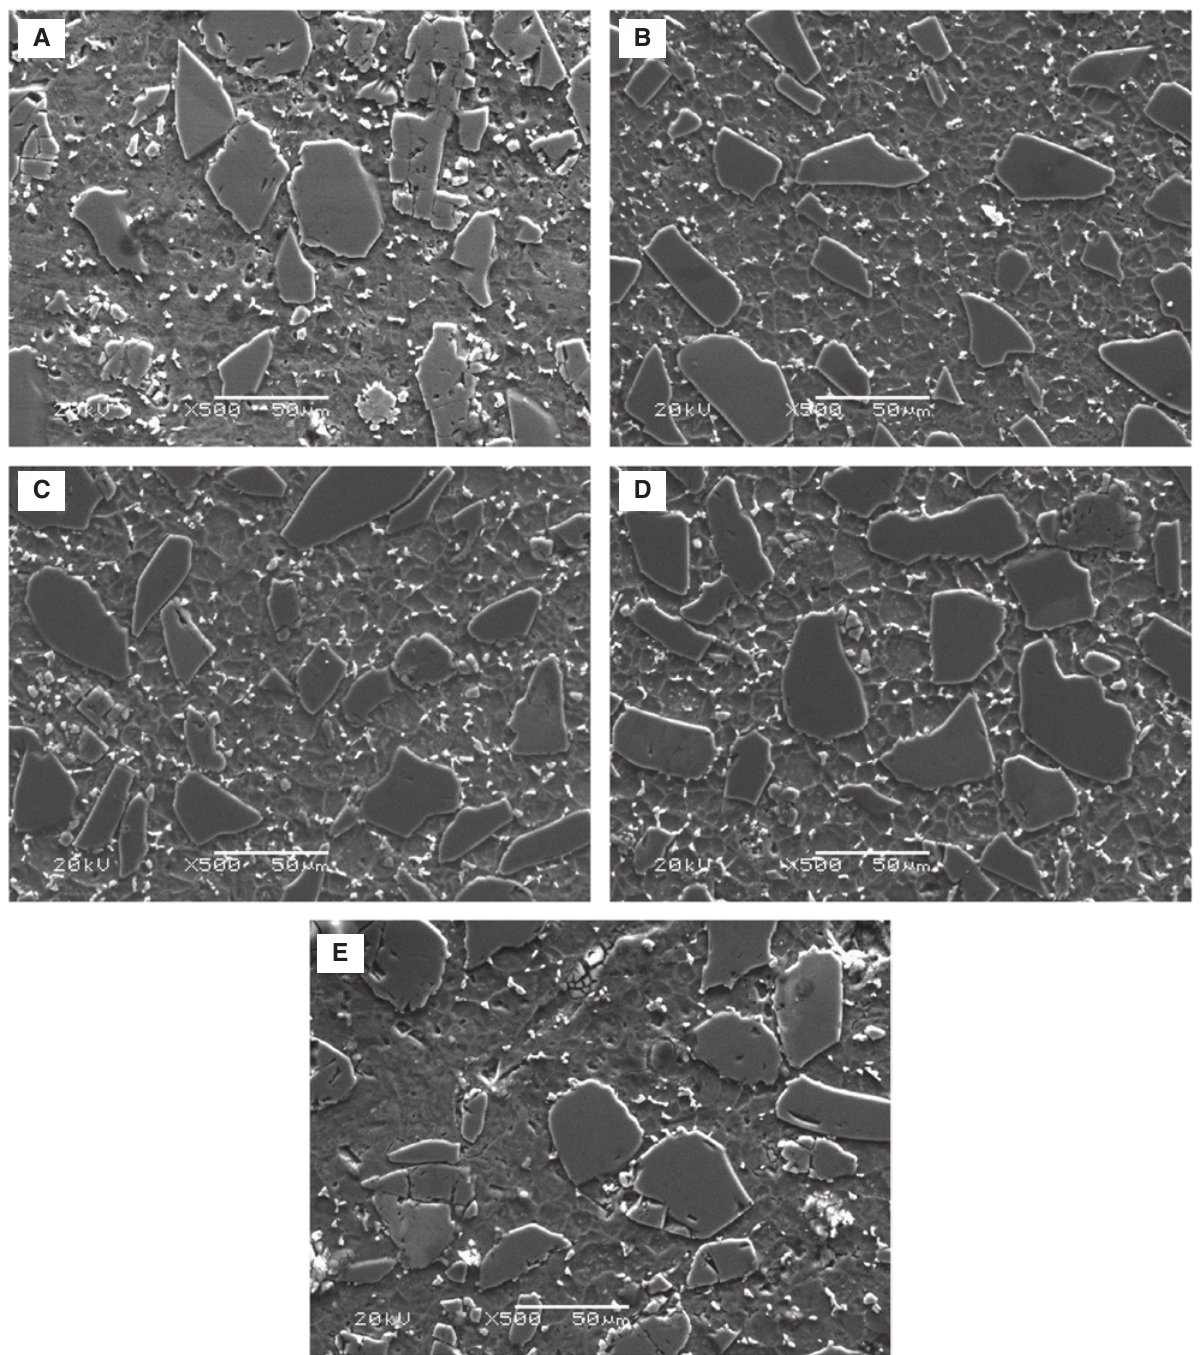
Figure 2 Back-scattered electron SEM micrographs of 30%SiCp/2024Al composites made at hot pressing temperatures of (A) 520 ° C,